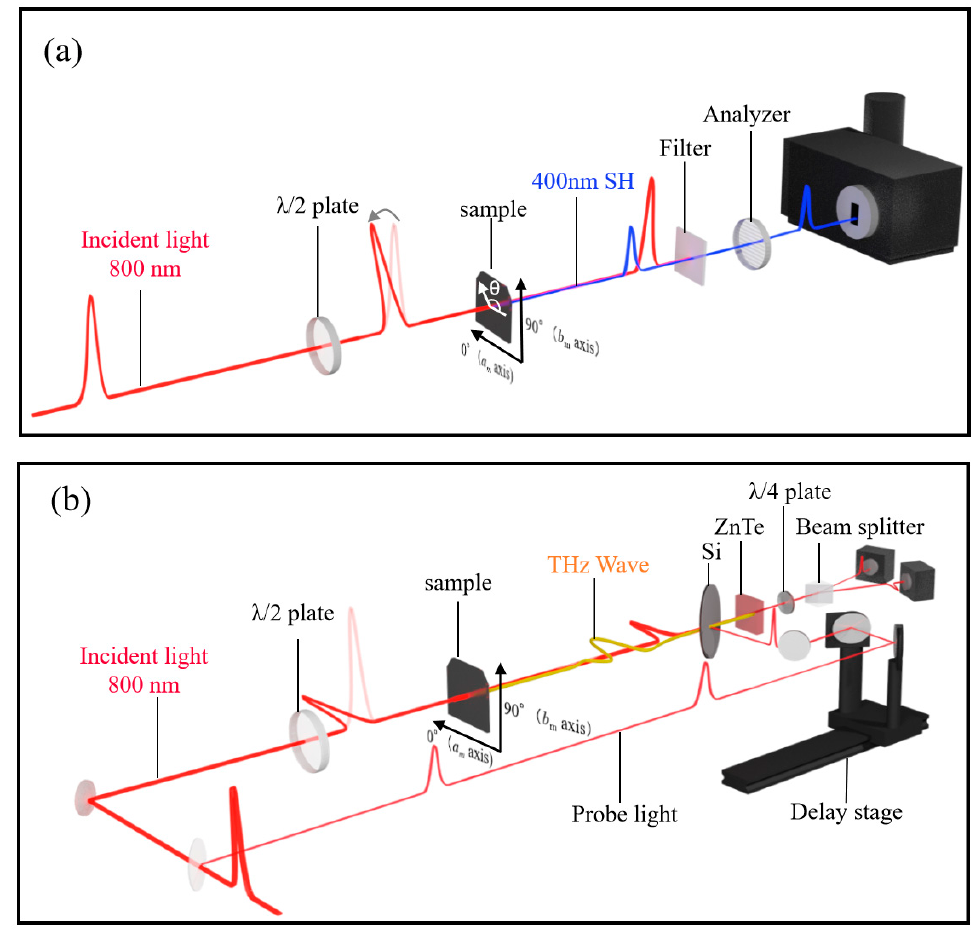
Figure 3. Schematic figures of the measurement systems of SHG ( a ) and terahertz radiation ( b ).